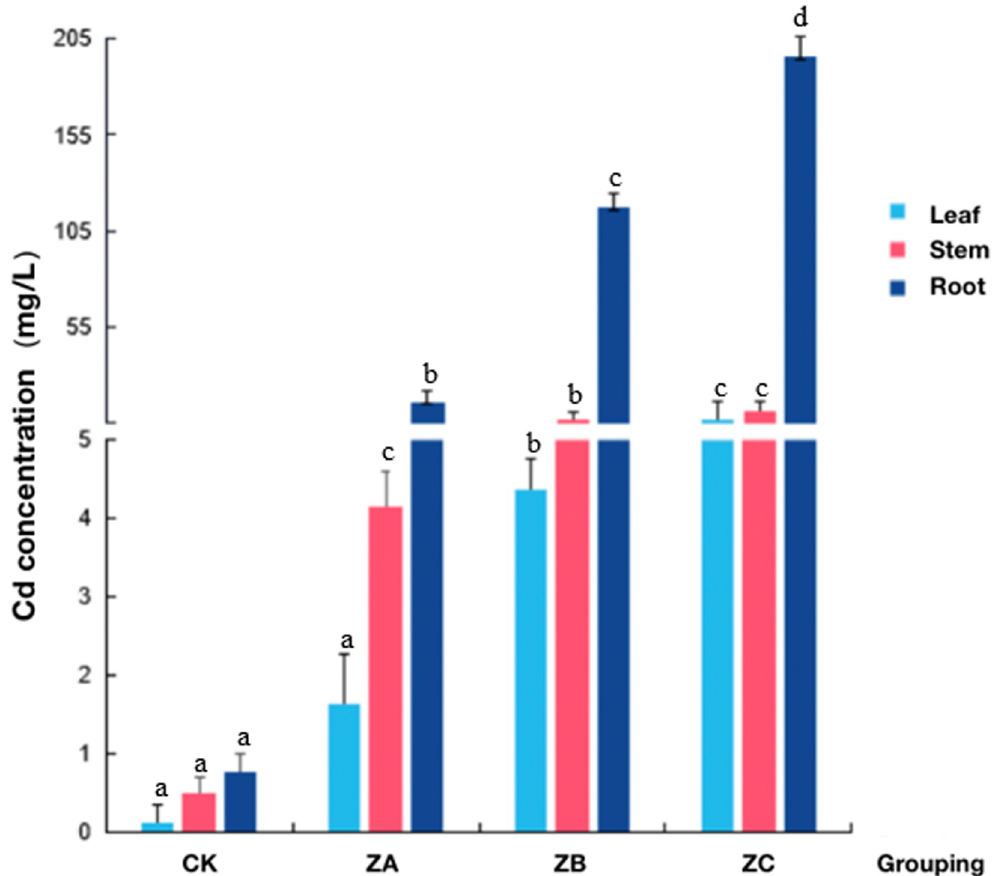
Fig 2. Cd concentration determination results of castor plants treated with different heavy metal Cd